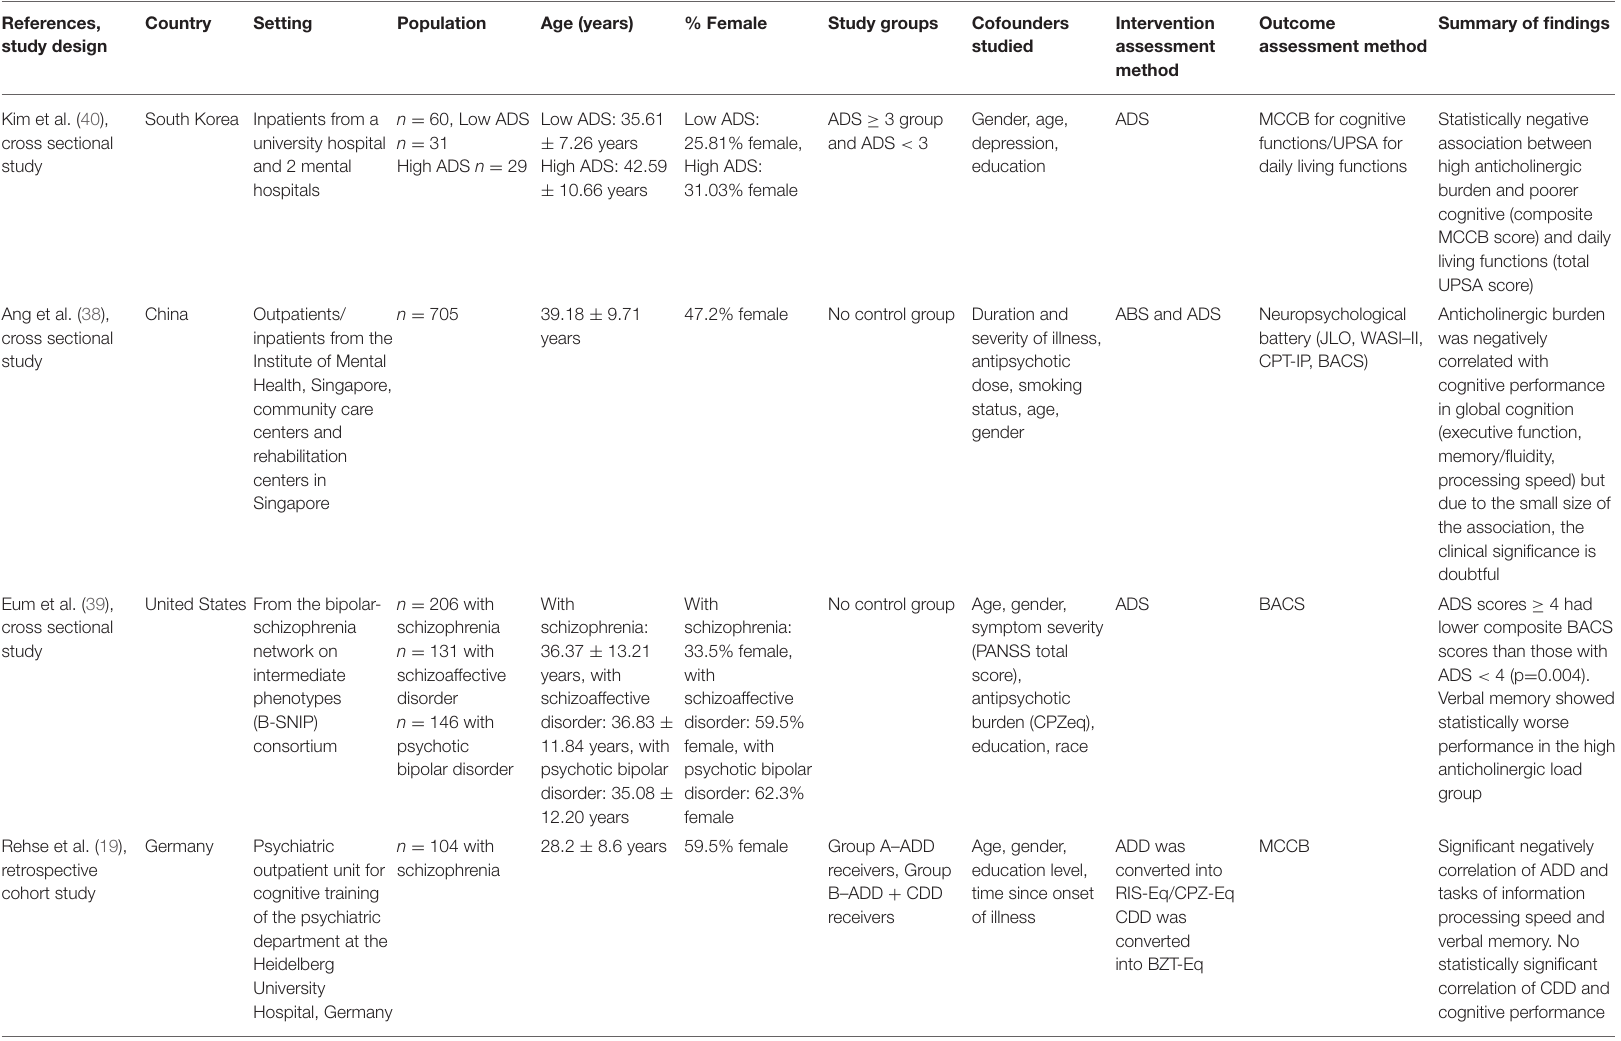
TABLE 2 | Qualitative analysis with the main characteristics of studies related to the influence of medication anticholinergic burden on cognition in